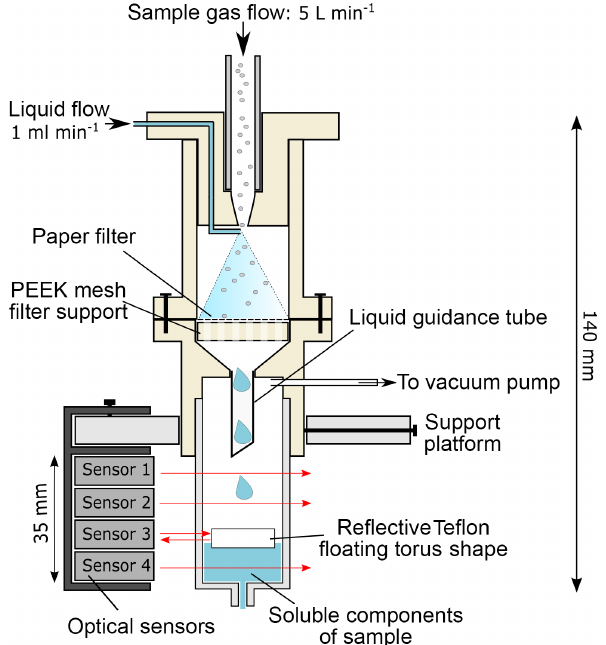
Figure 3. Schematic diagram of the particle collector allowing col- lection of particle-bound, water-soluble ROS components under mild extraction conditions. Addition of the reflective optical sensor system allows liquid height to be detected, controlled and kept con- stant, thus allowing automated measurement for extended periods of time under constant reaction